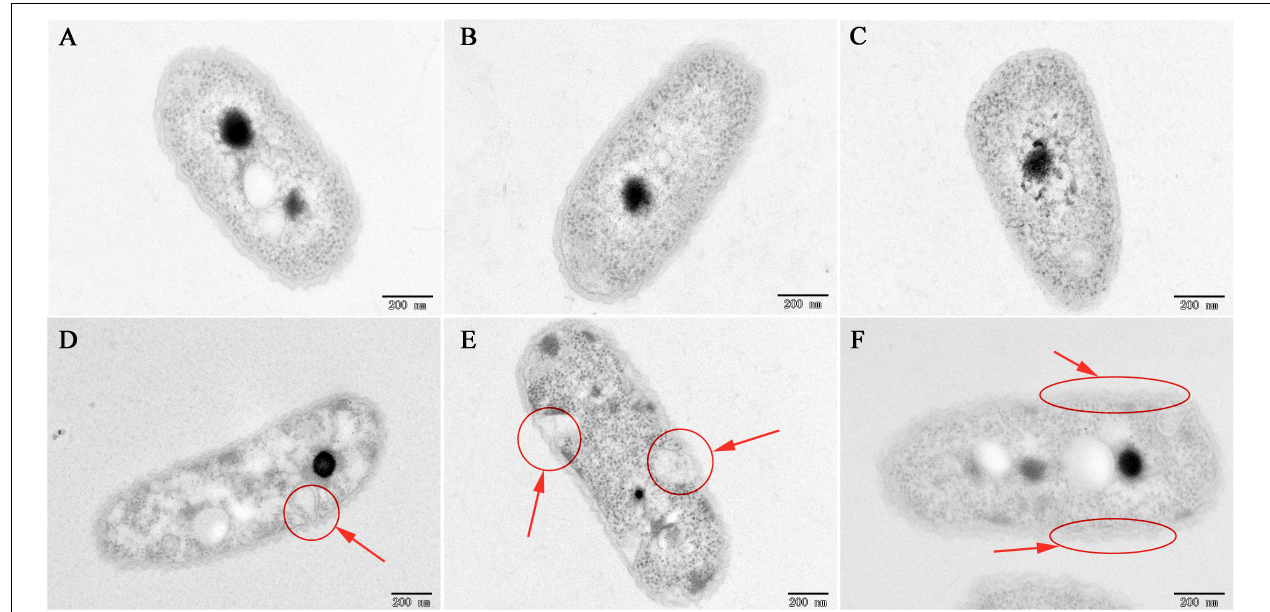
FIGURE 3 | TEM images of R. solanacearum cells treated with CA at a 200 µ g/mL concentration. (A–C) Untreated cells. (D–F) Cells treated with a 200 µ g/mL concentration of CA. Cells were incubated for 12 h with shaking at 180 rpm at 30 ◦ C. The red circle and arrows represent the damaged bacterial membranes and irregular cavities in cells (D,E) . The red ellipse and arrows represent the thinning and irregularity of the cell membrane in cells (F)